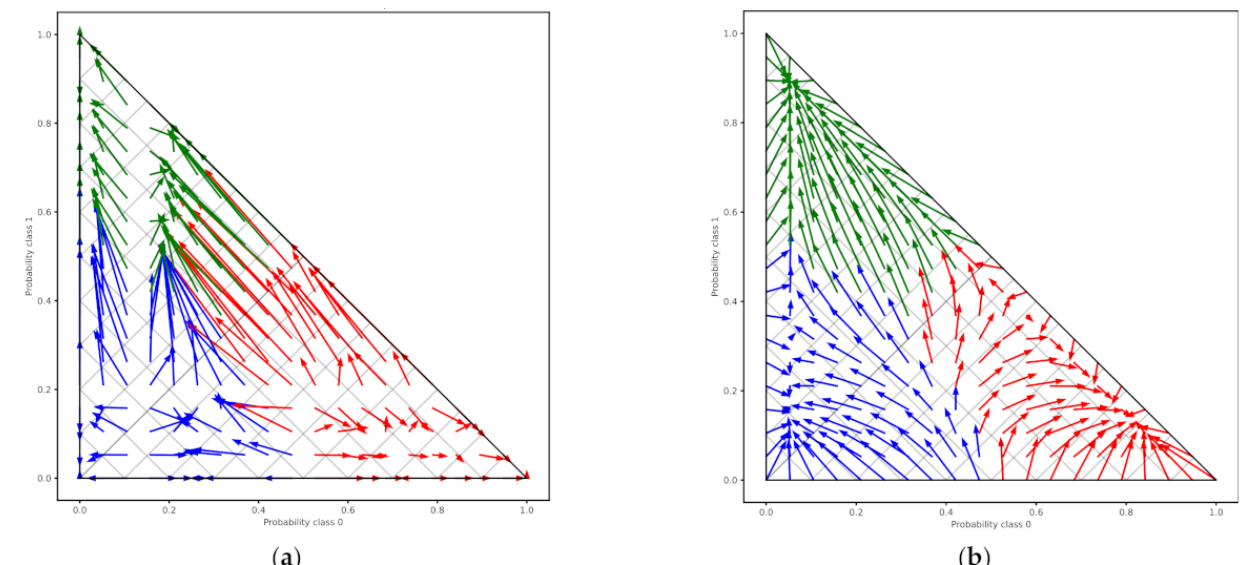
Figure 8. Learned calibration map with: ( a ) Isotonic Regression method; ( b ) Platt’s (sigmoid)